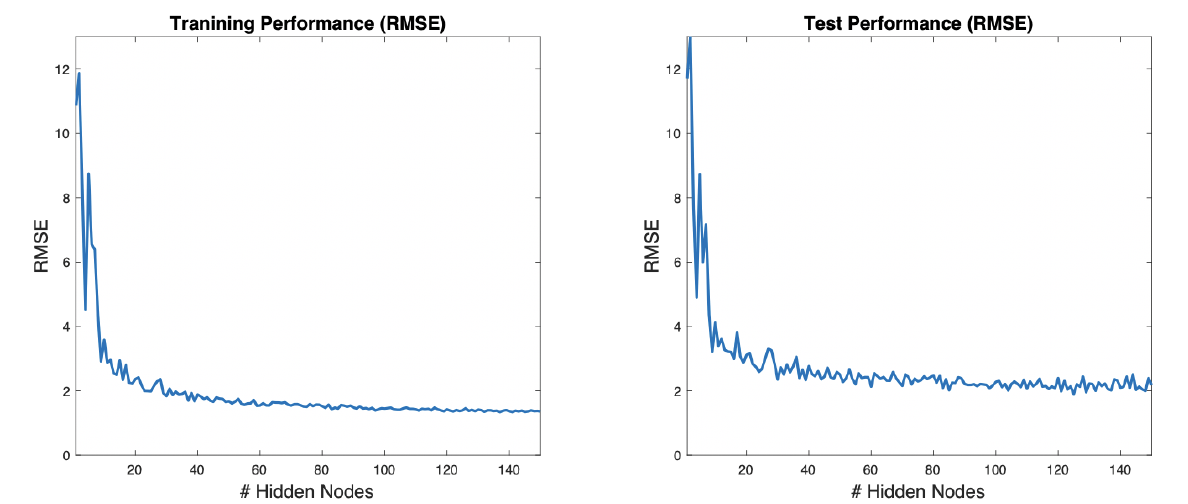
Figure 7. ( Left ) the Root-Mean-Square Error (RMSE) generated by a model of size H during the training step. ( Right ) the RMSE in the testing step for each H .